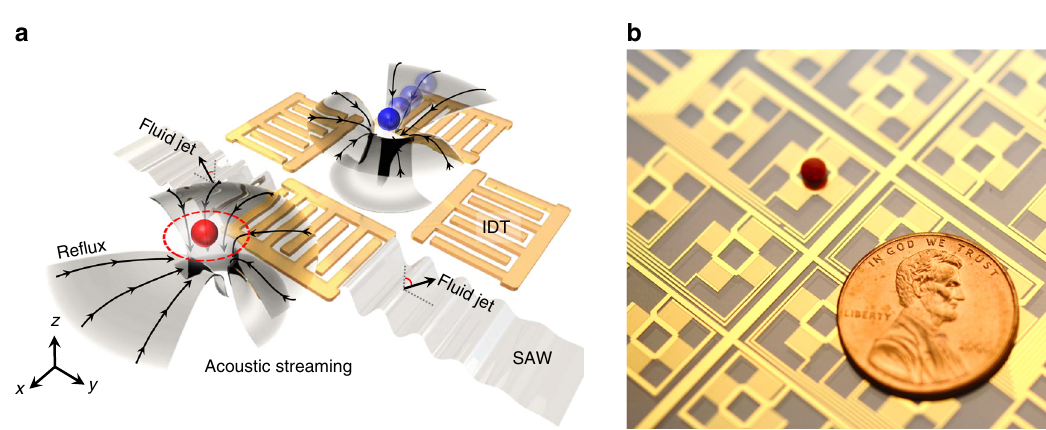
Fig. 1 Digital acousto fl uidics for contactless and programmable droplet manipulation. a Schematic showing one unit consisting of four IDTs (one pixel) in the digital acousto fl uidic device. The four IDTs can be selectively excited to translate droplets along the ± x and ± y directions. The aqueous droplets are isolated from the piezoelectric substrate by an inert carrier fl uid to prevent direct contact with surfaces. The IDT (bottom left) embedded beneath the carrier fl uid generates SAWs that pumps out fl uid in the ± y directions and pumps in fl uid in the ± x directions. The red and blue droplets are separately trapped at the two symmetric hydrodynamic wells near the fl anks of an IDT. The blue droplet is translated toward a well on the other side of the excited transducer. The re fl ux streamlines are shown in black. b A photo showing the digital acousto fl uidic device with a drop of blood fl oating on the carrier layer of fl uorinated